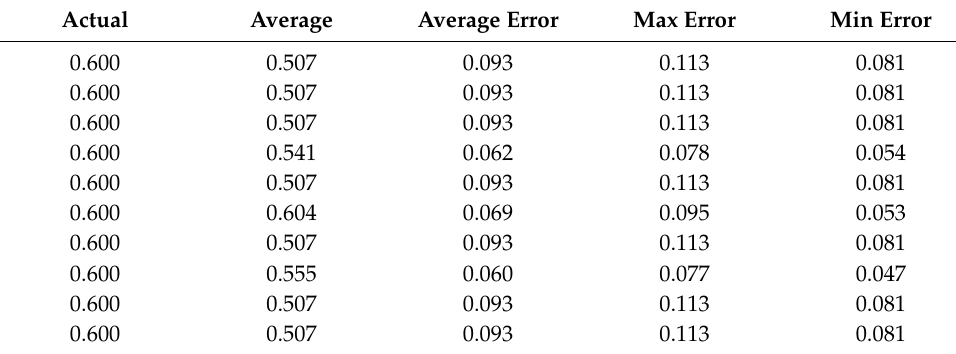
Table A188. Set 3, trials 21–30 data (all 0.5 PR